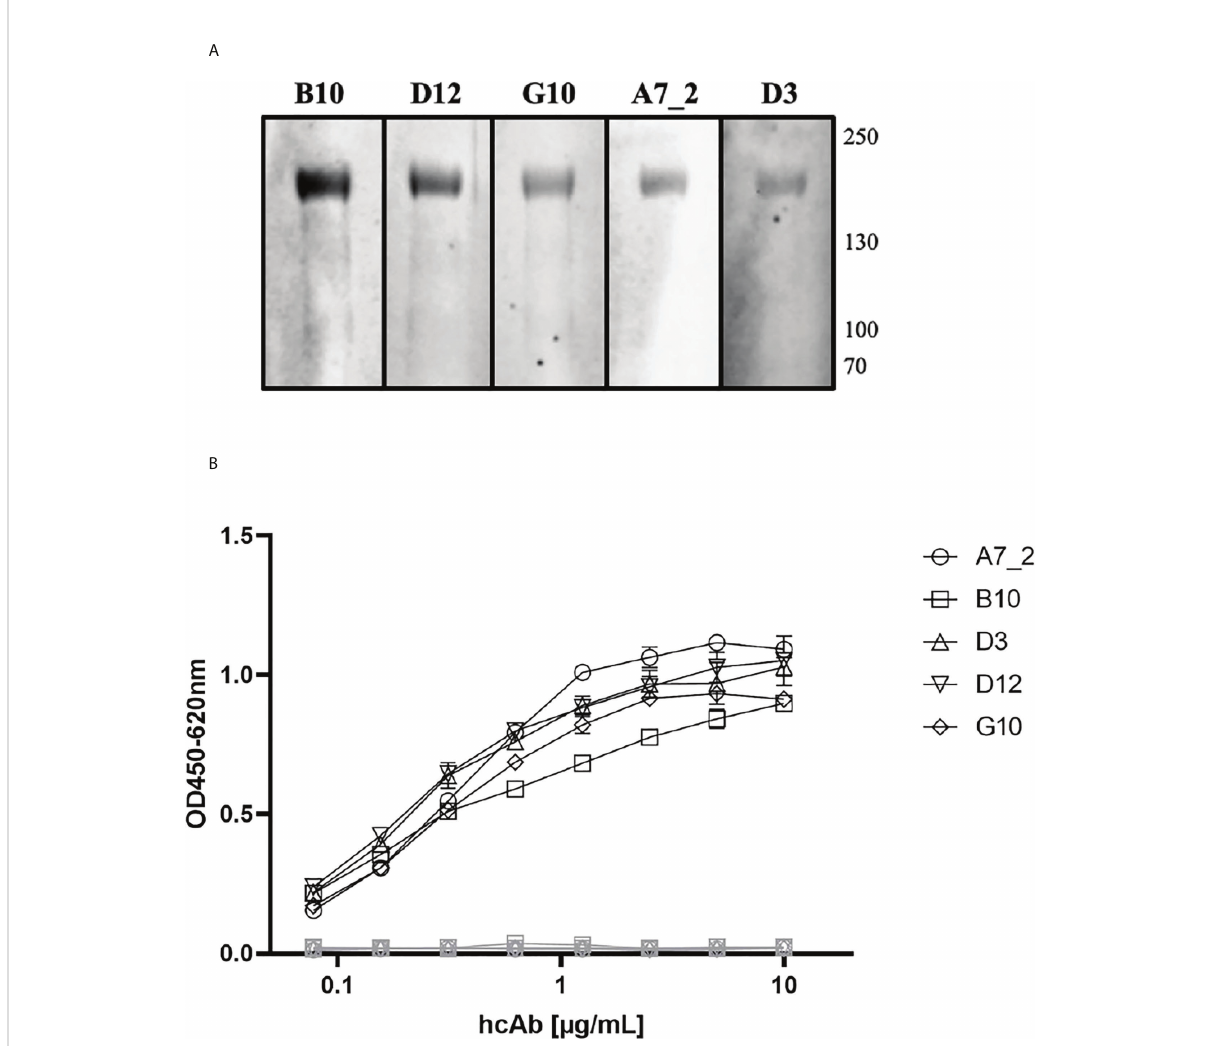
FIGURE 2 Characterization of SARS-CoV-2 Spike protein speci fi c VHHs. (A) Western Blot analyses. Recombinant Spike protein was applied to a 4-12% SDS polyacrylamide gradient gel and blotted using the NuPage system. HcAb candidates (1 µg/mL) were incubated for 18 h. Detection took place using a HRP-conjugated secondary antibody and WesternBright Sirius as substrate solution. Human reconvalescent serum (1:100) served as positive control. Reference HIS-tagged protein (0.25 µg/mL) was used as negative control. (B) Indirect ELISA with recombinant SARS-CoV-2 Spike protein as antigen. Wells were coated with antigen (SARS-CoV-2 Spike protein, 3 µg/mL) and blocked with 100 µL/well PBS/1% casein. HcAbs were added in different dilutions. Detection was performed with a HRP-conjugated secondary antibody (ABIN1981272, 1 µg/mL) and optical density was measured at 450 nm with a reference wavelength of 620 nm. Blocking reagent and a His-tagged reference protein served as negative control. Mean and standard deviation of three independent measurements is